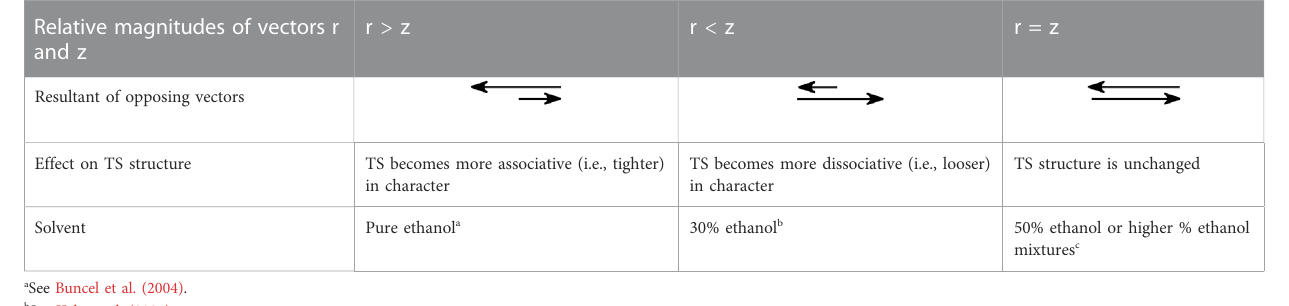
TABLE 4 The relative magnitudes of the vectors r and z in Figure 2 and their effects on the structure of the concerted TS for the reaction of 8b with HO - and PhO - nucleophiles in aqueous ethanol solvents (entries 12b, 13, 14b, and 15 in Table 1). From Kalu et al. (2022), reproduced by permission of the Royal Society of